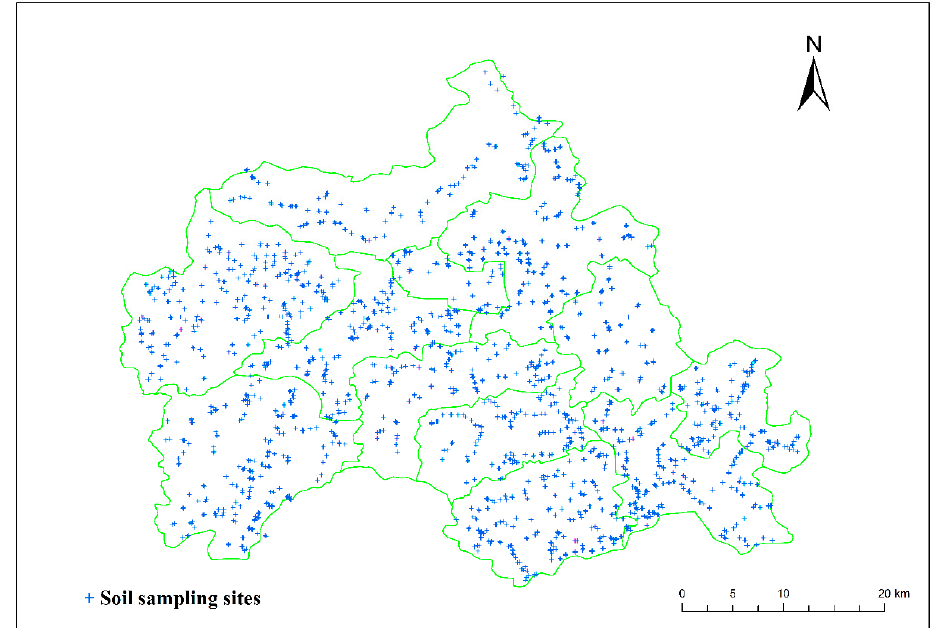
Figure 3. Distribution of farmland soil sampling